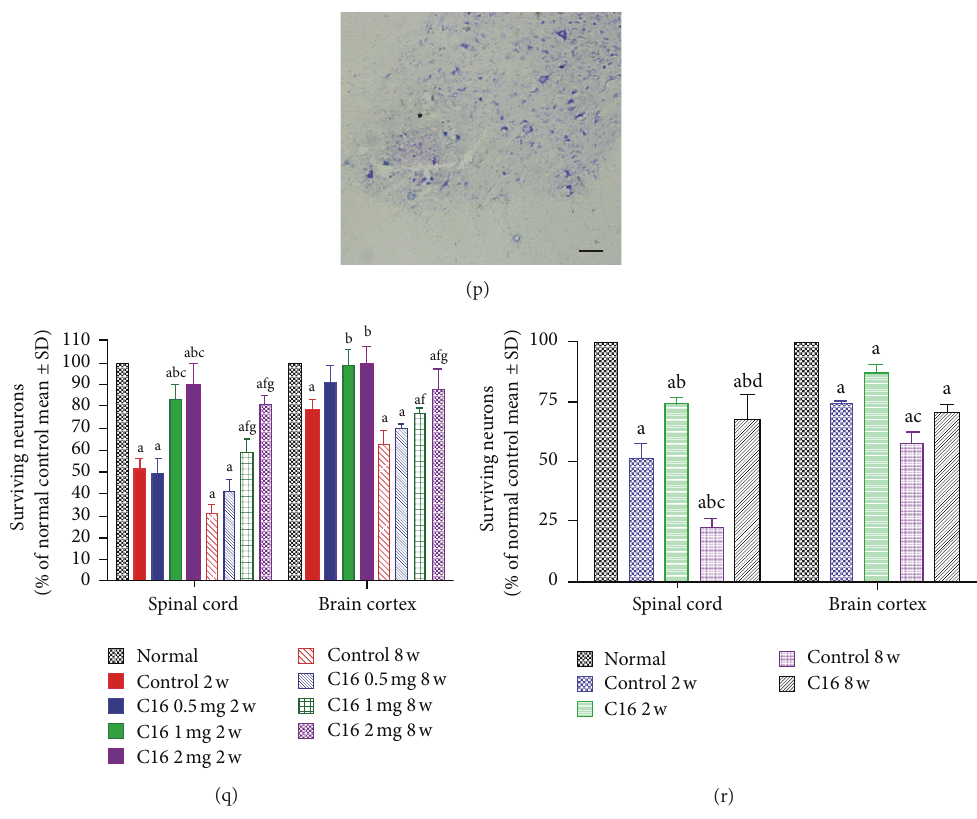
Figure 12: C16 treatment reduced the loss of neurons both in spinal cord and brain. Nissl staining; bar = 100 𝜇 m. ((a), (c), (e), (g), (i), (k), (m), and (o) coronal sections of motor cortex; (b), (d), (f), (h), (j), (l), (n), and (p) traverse section through the lumbar spinal cord). At week 2 after immunization, normal rats group ((a), (b)), vehicle control rats ((c), (d)), 2 mg/per day C16 treated EAE rats ((e), (f)), and C16 late treated EAE rats ((g), (h)). At week 8 after immunization, vehicle control rats ((i), (j)), 0.5 mg/per day C16 treated EAE rats ((k), (l)), 2 mg/per day C16 treated EAE rats ((m), (n)), and C16 late treated EAE rats ((o), (p)). (q) C16 treatment increased the surviving neural cells (% of the normal rats) in different dose groups, calculated after Nissl staining. a 𝑃 < 0.05 versus normal rats; b 𝑃 < 0.05 versus vehicle control rats at week 2 postimmunization group; f 𝑃 < 0.05 versus vehicle control rats at week 8 after immunization. g 𝑃 < 0.05 versus 0.5 mg/per day C16 treated EAE rats at week 8 after immunization. (r) Late treated C16 treatment also lessened the loss of neurons to a certain extent. a 𝑃 < 0.05 versus normal rats; b 𝑃 < 0.05 versus vehicle control rats at week 2 postimmunization group; c 𝑃 < 0.05 versus C16 treated EAE rats at week 2 postimmunization group; d 𝑃 < 0.05 versus vehicle control rats at week 8 after